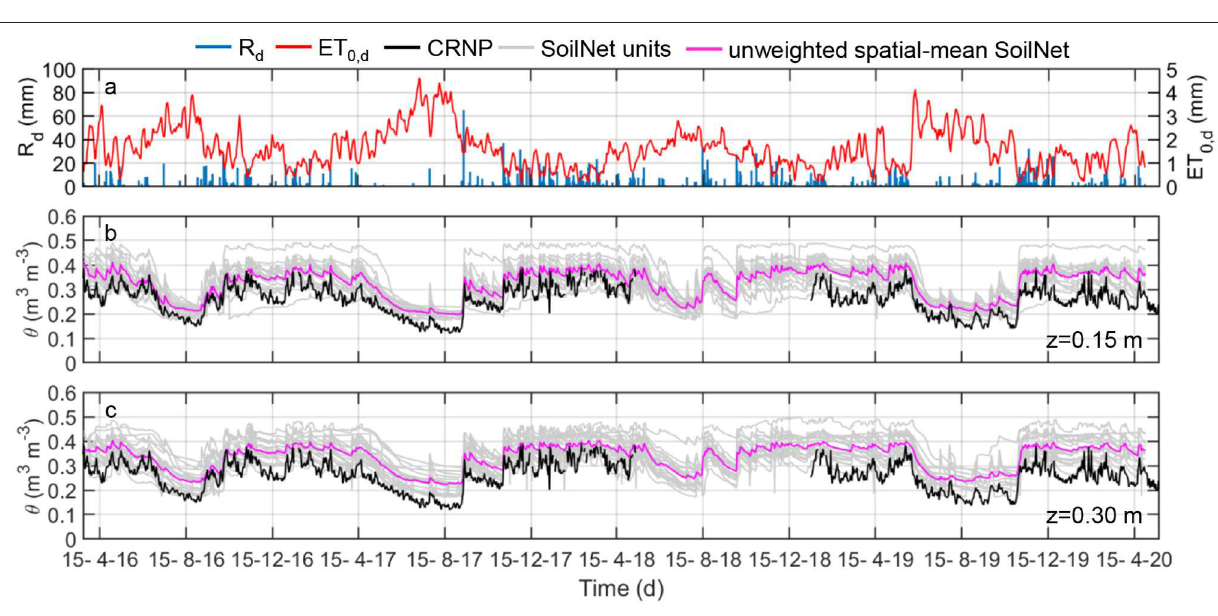
does not have a clear and shared definition and is still